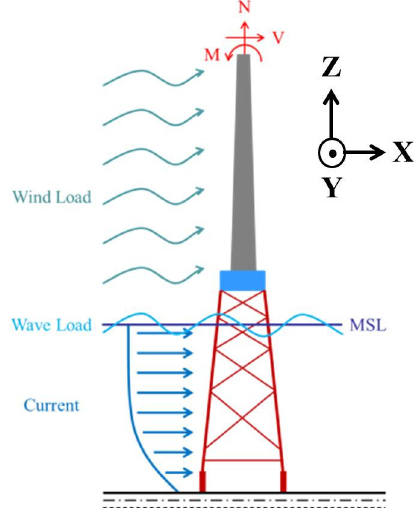
Figure 15. Loadings for Jacket Support Structure. MSL: Mean Sea Level; M: Moment; N: Normal Force; V: Shear Force.